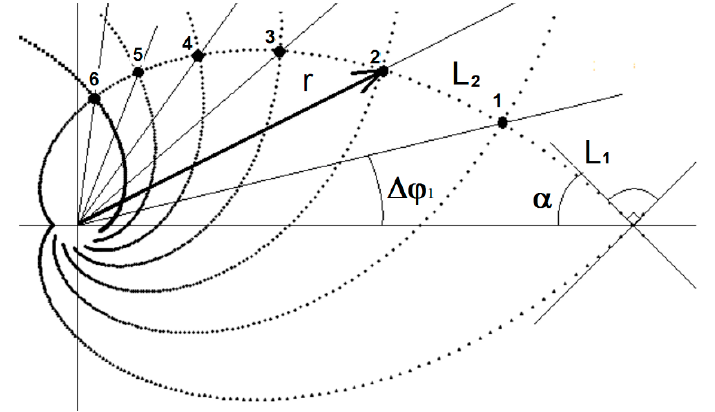
Figure 7. Orthogonal logarithmic spiral divided by gold section ( k = 1, Δϕ 1 = 27.5° and α = 45°).